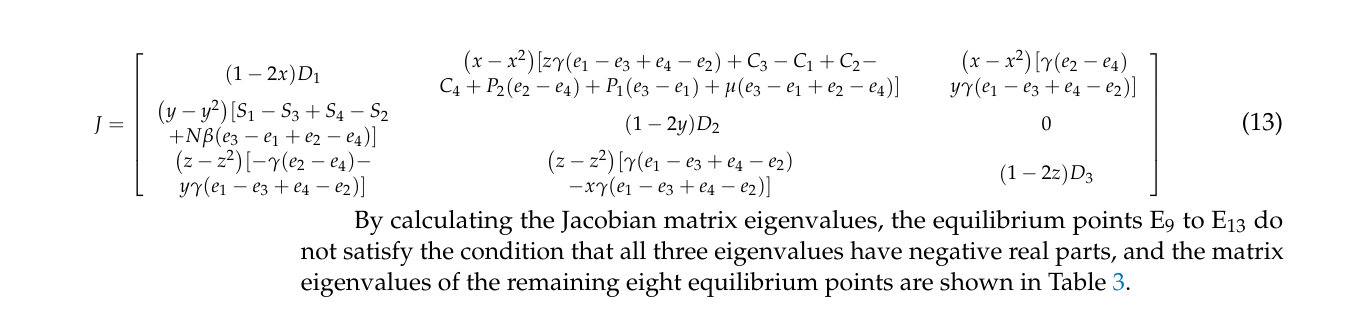
Table 3. Eigenvalues of Jacobian matrix for equilibrium points.